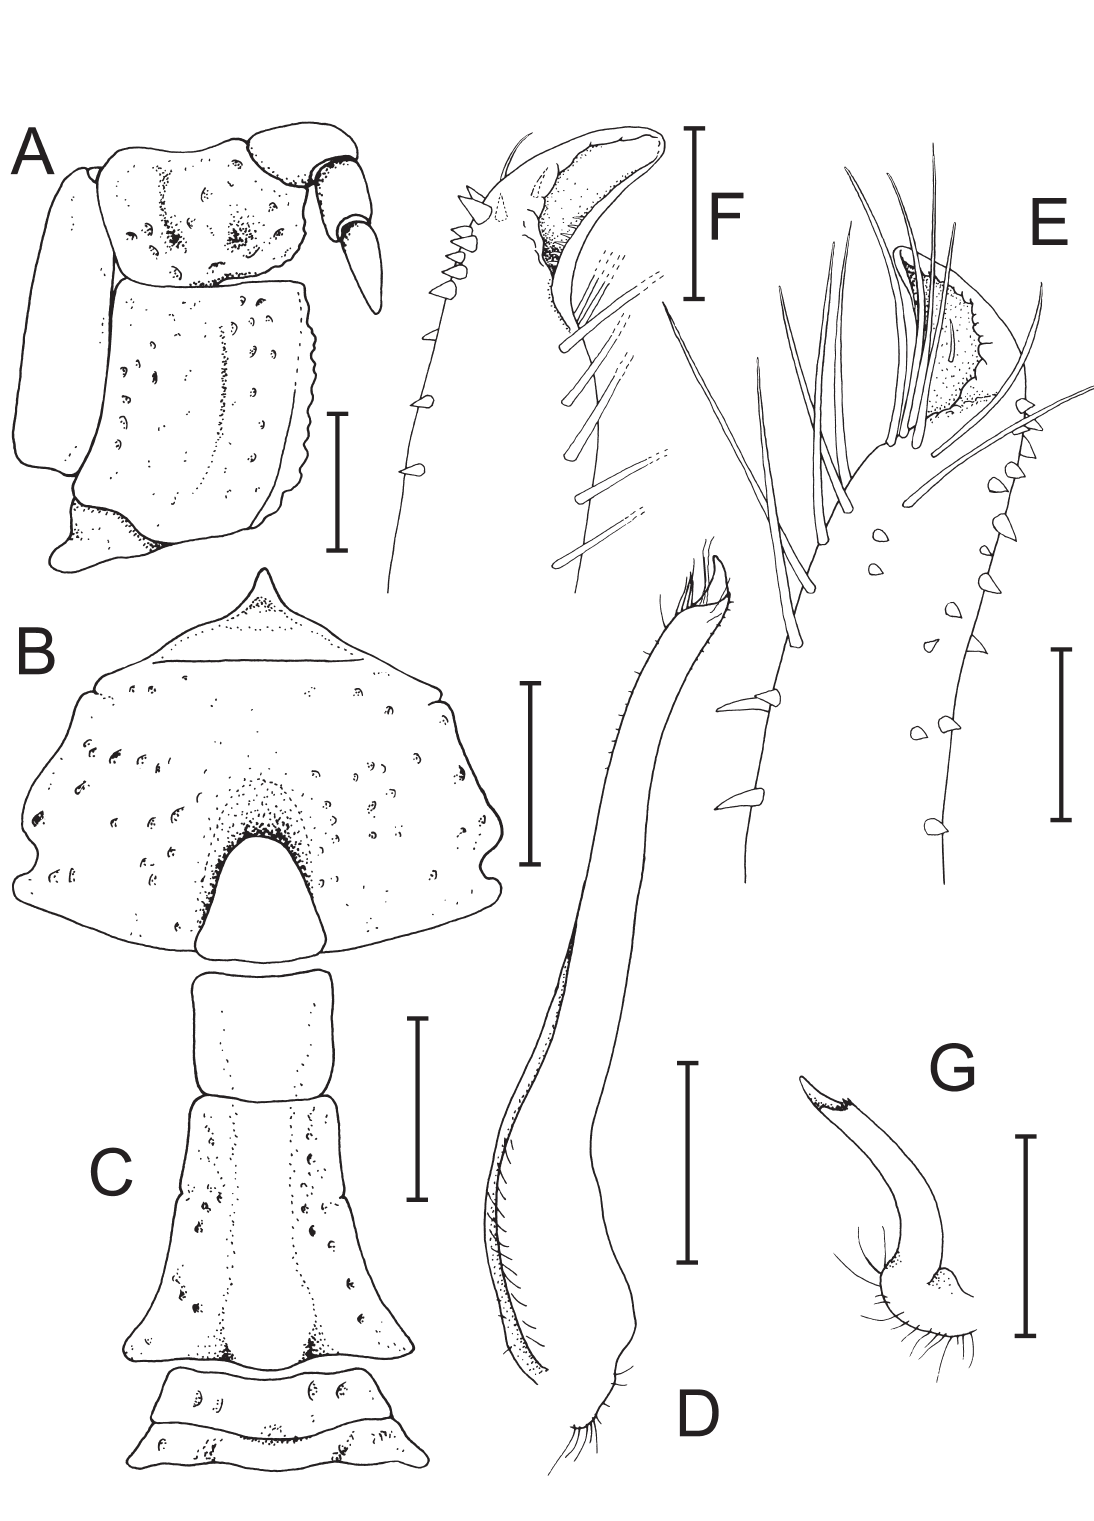
Fig. 5. Actaea grimaldii sp. nov., holotype, ♂, 6.2 × 4.4 mm (MNHN IU 2013-921), Papua New Guinea. A . Right third maxilliped (setae not drawn). B . Anterior thoracic sternum (sternites 1–4) and telson. C . Abdominal somites 1–6. D . Ventral view of left G1. E . Ventral view of distal part of left G1. F . Dorsal view of distal part of left G1. G . Left G2. Scale bars: A, D, G = 0.5 mm; B–C = 1.0 mm; E–F = 0.1